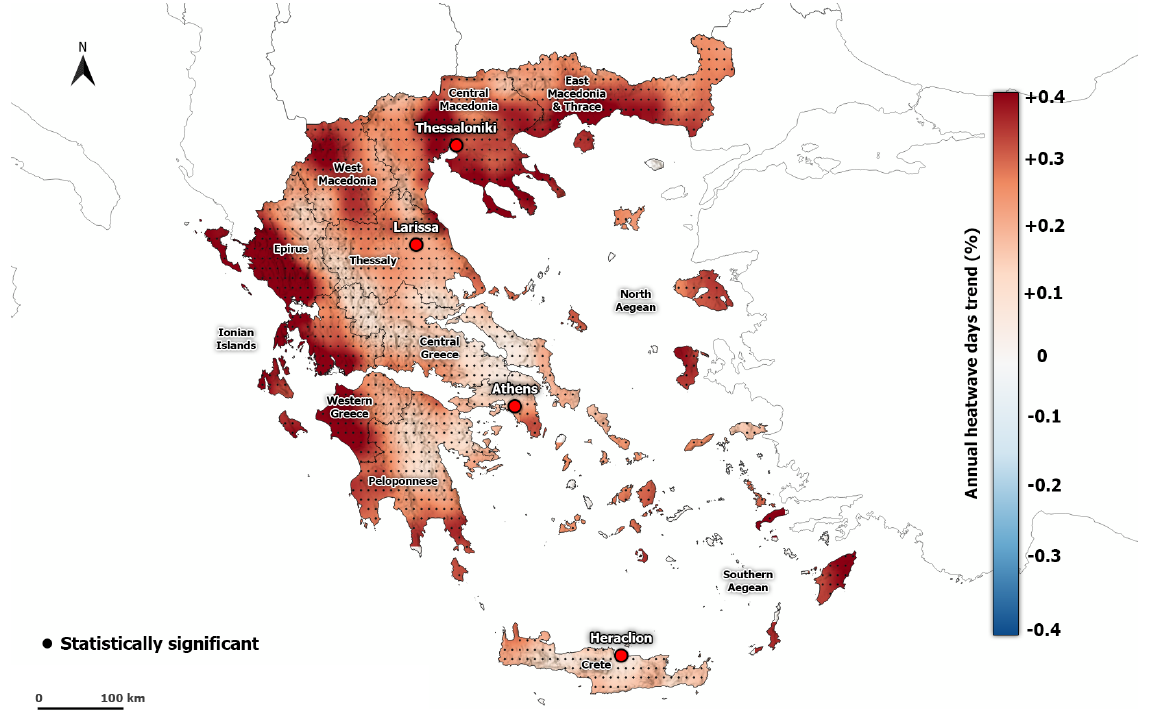
Figure 7. Spatial distribution of summer HWF trend (% per decade) calculated from ERA5-Land during the period 1950–2020. Dots indicate significant trends at the 95% level.